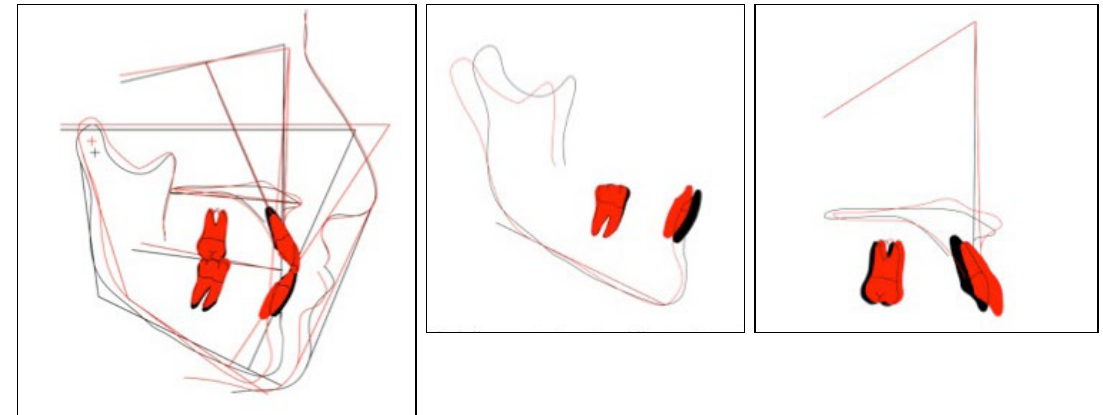
Figure 8. Cephalometric superimpositions. Black line, pretreatment; red line, post-treatment.